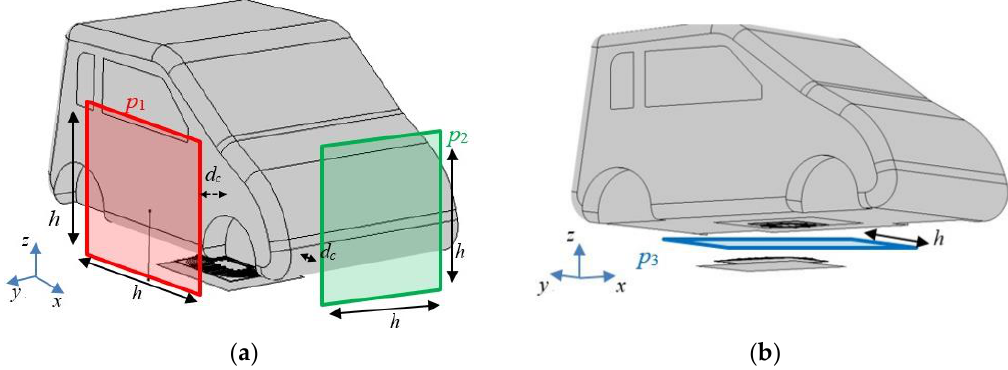
Figure 20. Calculation planes for the magnetic field: p 1 , p 2 (a) and p 3 (b) .